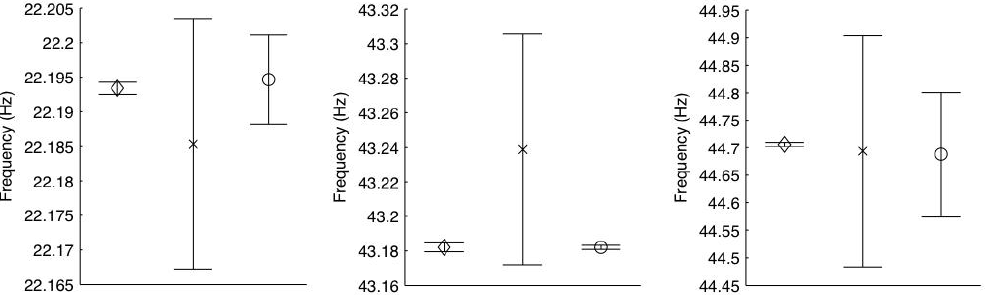
Fig. 13. Results of cluster analysis: Damped resonance